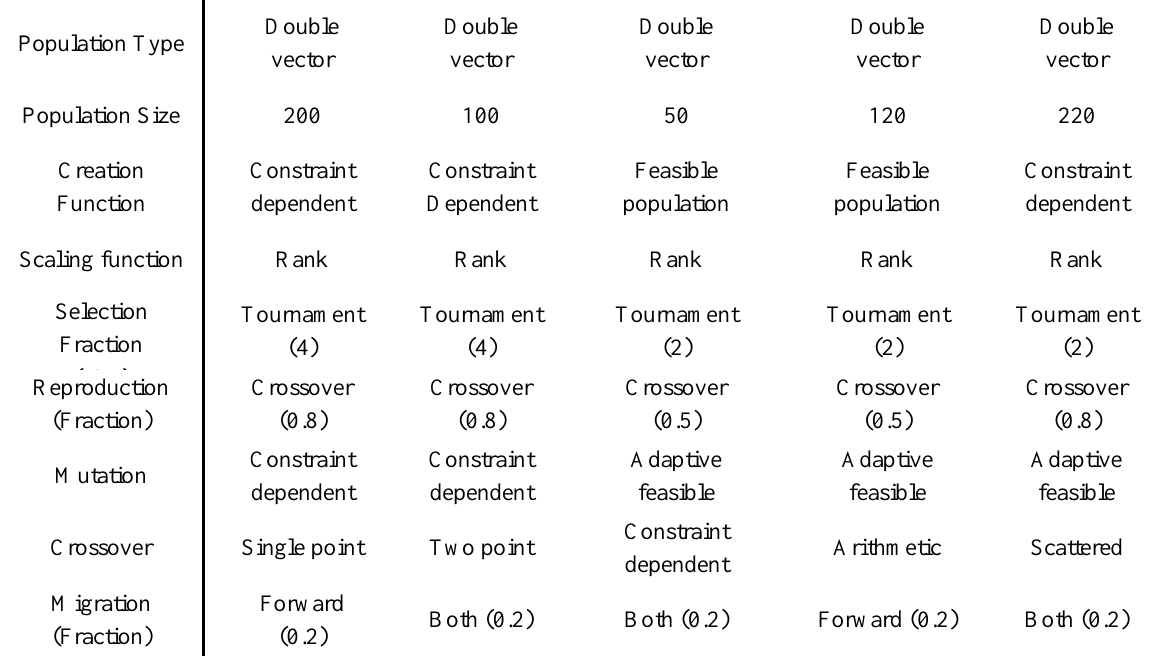
Table 1. Different genetic algorithm options used for five